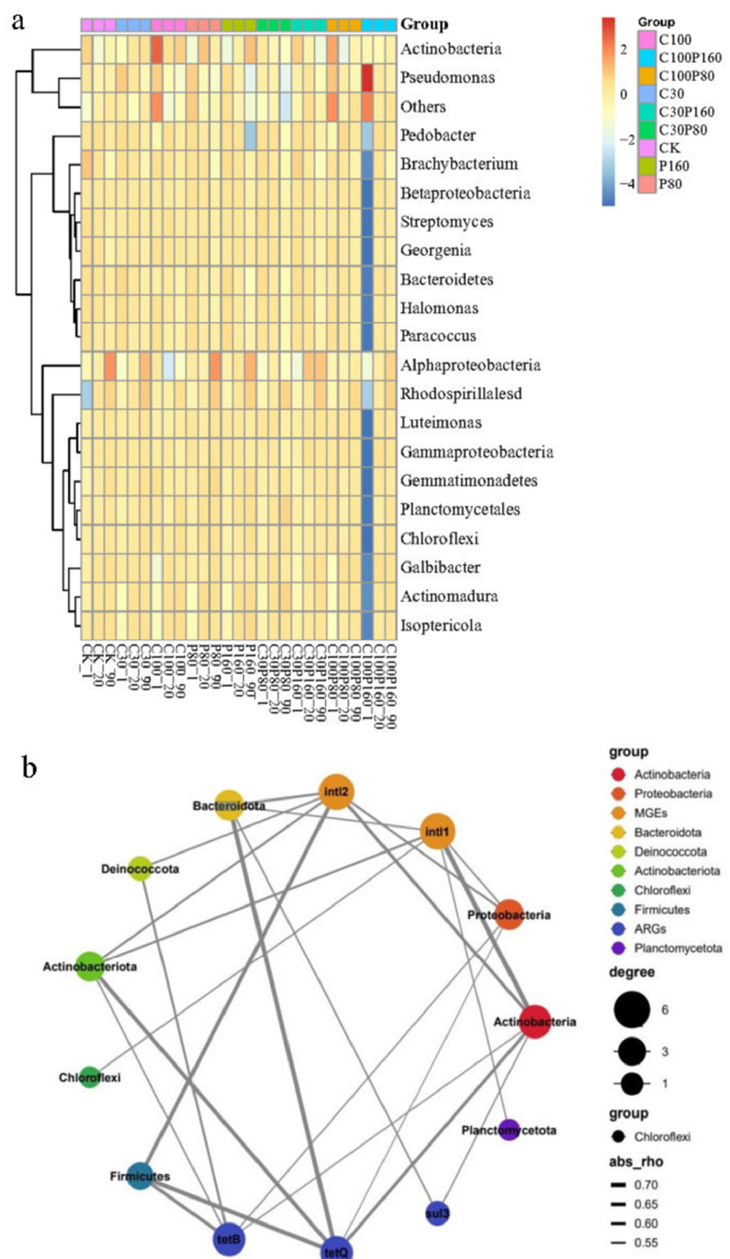
Figure 5. ( a ) Relative abundance heat map of top 20 genera in each treatment; ( b ) network analysis shows the relationship between ARGs, MGEs, and potential host bacteria (including the top 30 bacterial genera).